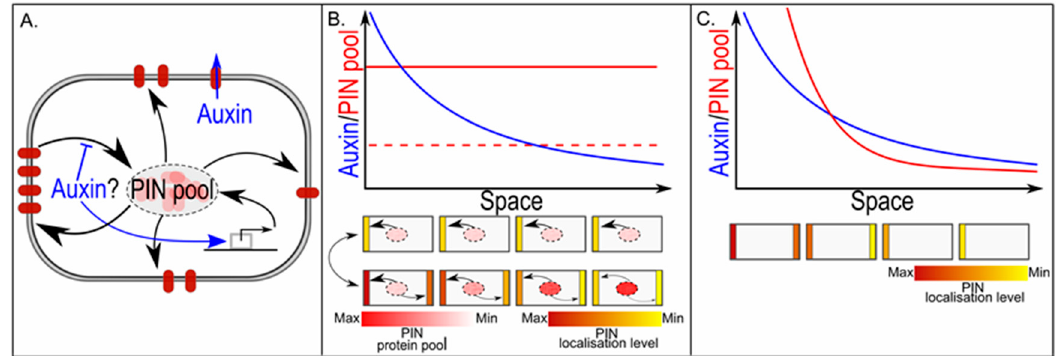
Figure 5. In PIN polarisation, the cellular PIN pool size determines graded versus all-or-none polarisation. ( A ) Gene expression is a major determinant of overall cellular PIN pool size. Individual membrane compartments derive their PINs from this single shared PIN pool, and PINs not deposited on the membrane together constitute the remaining cytoplasmic PIN pool; ( B ) The upper graph shows a hypothetical auxin gradient across a one-dimensional tissue. We assume an up-the-gradient type of feedback on PIN localisation. If the overall cellular PIN pool is small, all-or-none polarisation occurs and all cells show the same polarity pattern with high amounts of PINs on the highest concentration facing membrane and low or absent PINs on the lowest concentration facing membrane, and few PINs left in the cytoplasmic PIN pool (middle figure). If the overall cellular PIN pool is large, PIN levels on each individual membrane depend on the auxin level they experience, resulting in a graded polarity pattern with amount of polarity and amount of PINs on highest and lowest concentration facing membranes increasing along the gradient, and amount of PINs remaining in the cytoplasmic gradient decreasing along the gradient (lower figure); ( C ) The upper graph shows again a hypothetical auxin gradient that now induces a gradient in overall cellular PIN pool sizes. For small PIN pools, all-or-none polarisation occurs; for larger PIN pools, polarisation becomes graded with auxin levels, while for very large PIN pools, apolar PIN patterns arise.